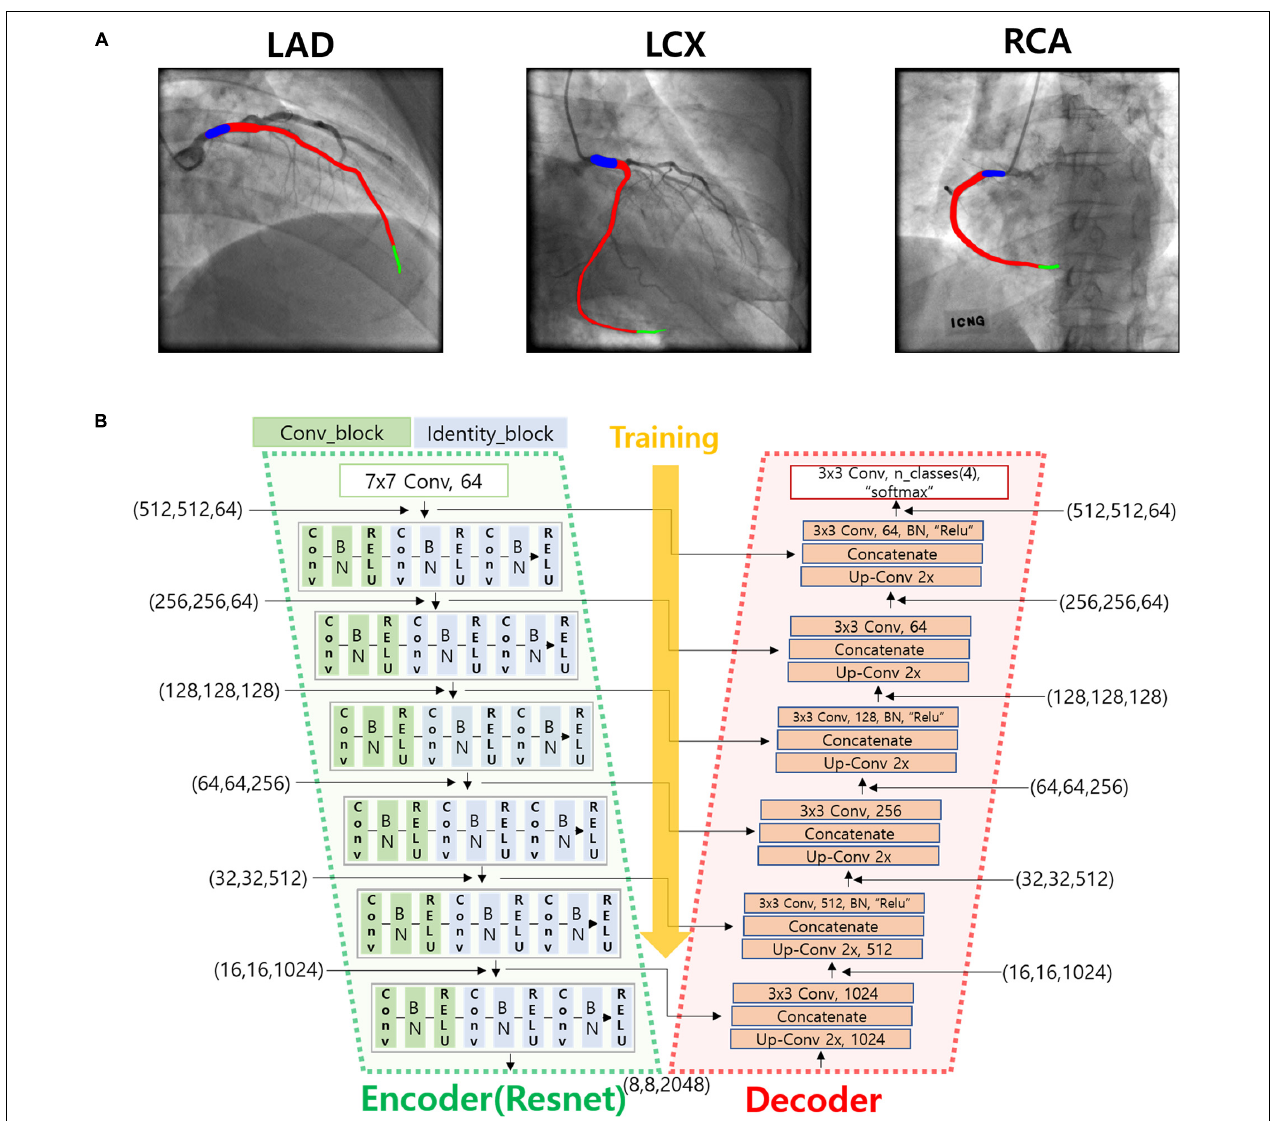
FIGURE 1 | Deep learning method for the identification of the two ends of the vessel. (A) An example of the labeling of the two ends (blue and green) and the vessel inside (red) for LAD, LCX, and RCA. (B) Deep learning network used for the training of the labeled images.